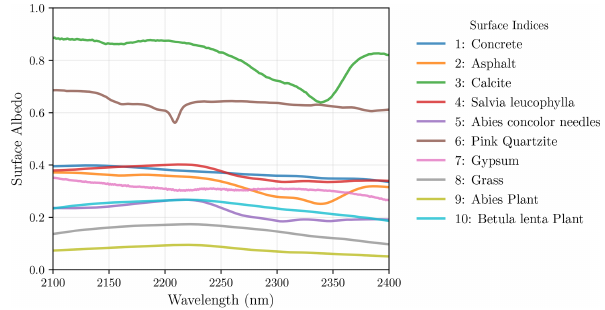
Figure 3. Albedo spectral variations near 2.3µm from distinct sur- face reflectances in our